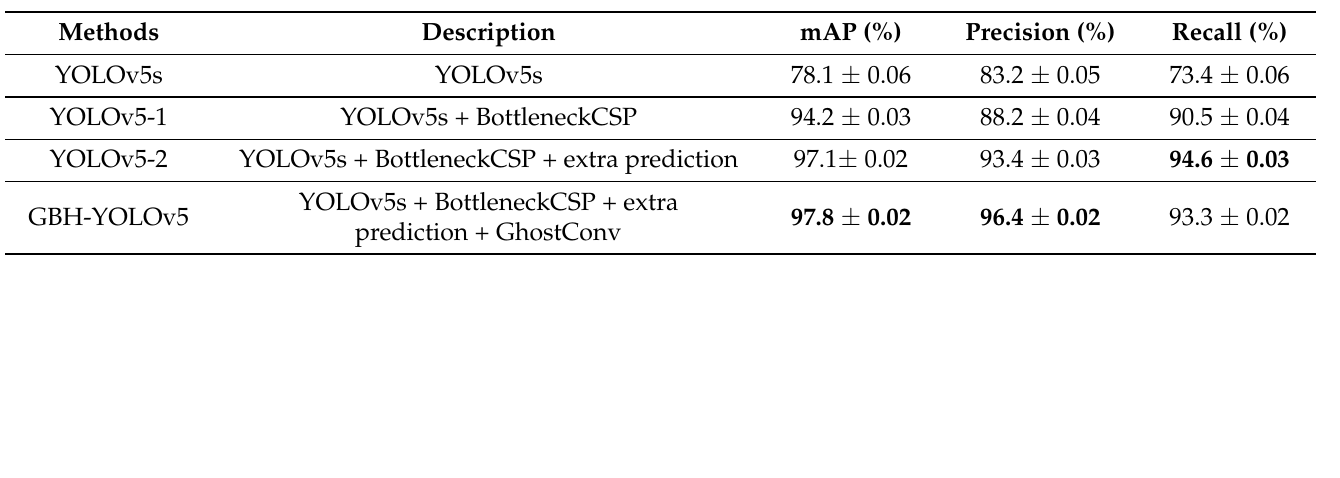
Table 4. Ablation Study of PV Multi-Defect datasets, based on 95% confidence